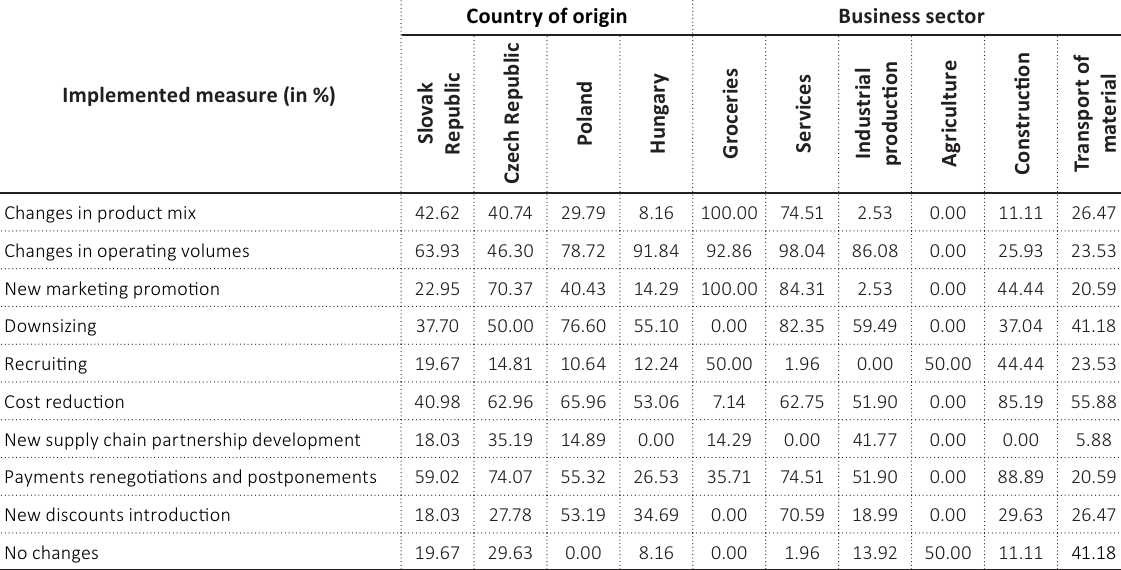
Implemented measure (in